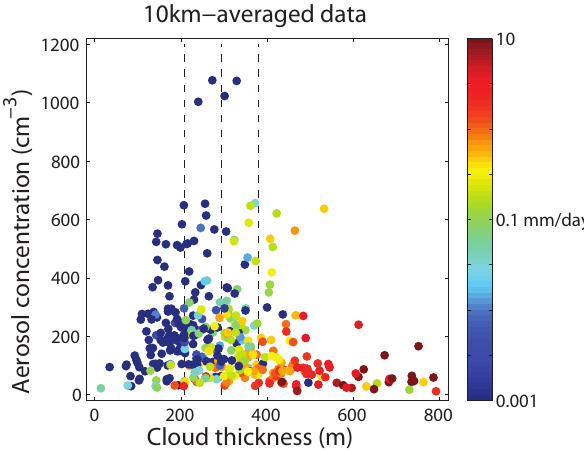
Fig. 1. Distribution of 10km-averaged aerosol concentration and cloud thickness measurements taken during twelve research flights. Colors indicate cloud base precipitation rates derived from the cloud base reflectivities that were measured by the Wyoming Cloud Radar. Dotted lines indicate the boundaries of the cloud thickness bins de- scribed in the